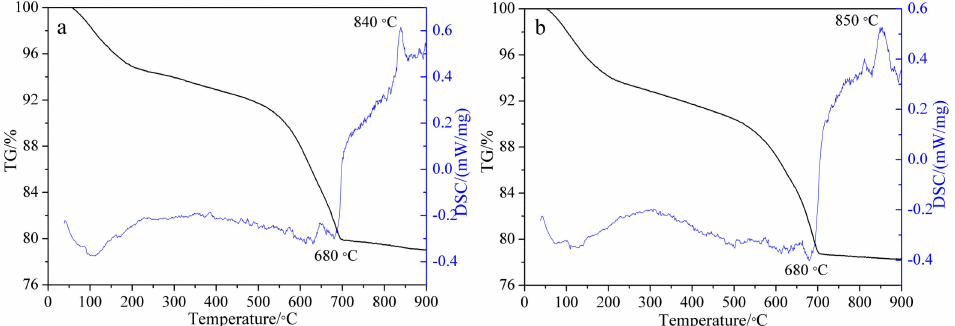
Figure 4. TG–DSC spectra of tobermorite and Al-substituted tobermorite with Al / (Al + Si) molar ratio of 0.15. ( a ): Al / (Al + Si) = 0, ( b ): Al / (Al + Si) =